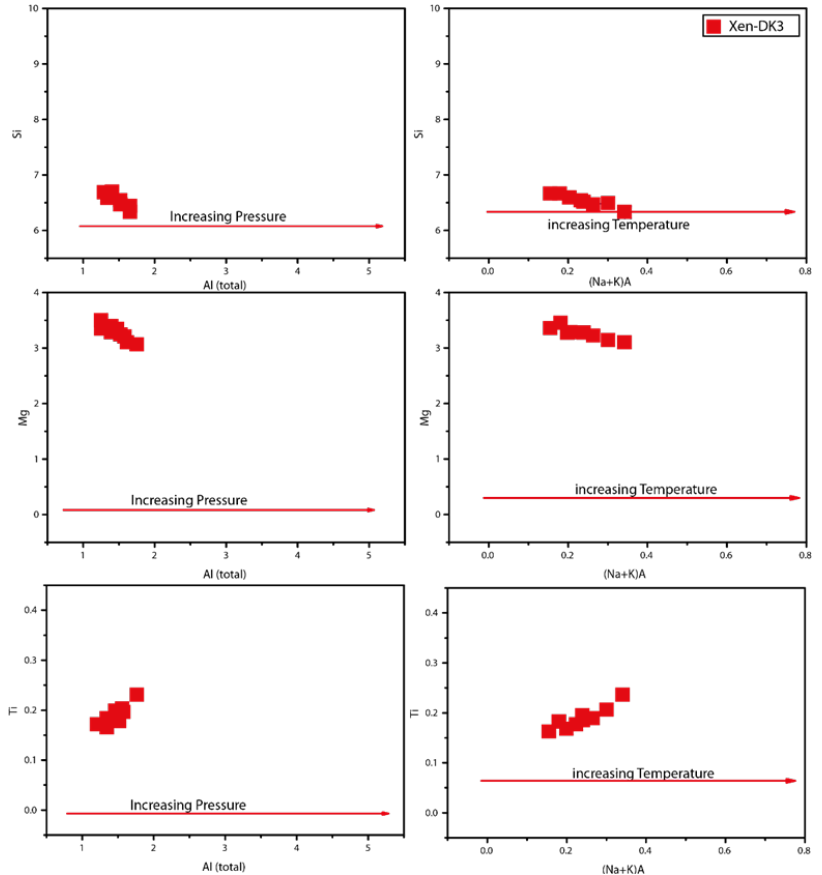
Figure 11. The Al (total) vs. Ti, Mg, Si and (Na+K)A diagram vs. the Ti, Mg, Si for the study of chemical composition changes in dioritic enclaves. Associated inferred pressure and temperature changes are indicated with red arrows.